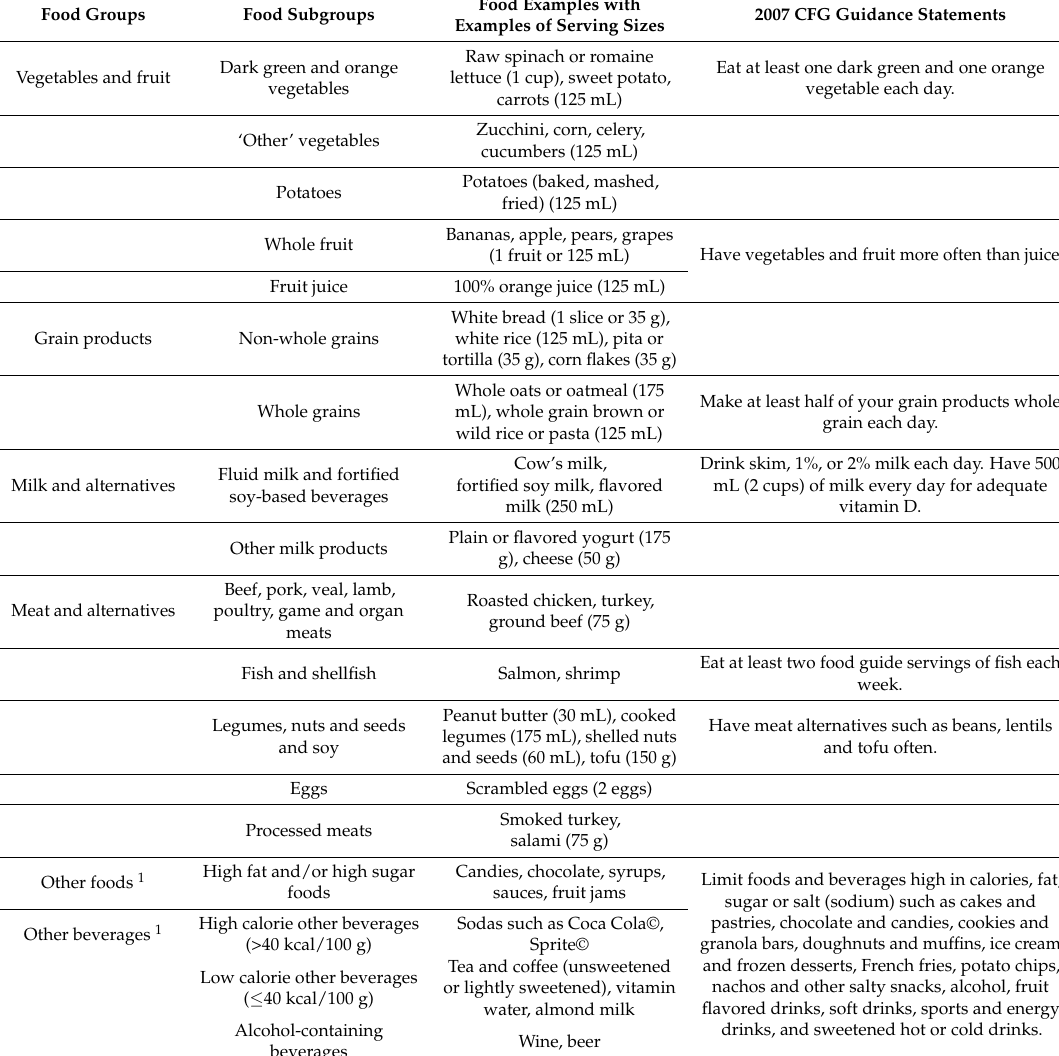
Table 1. Description of the food groups and food subgroups in the 2007 CFG food grouping